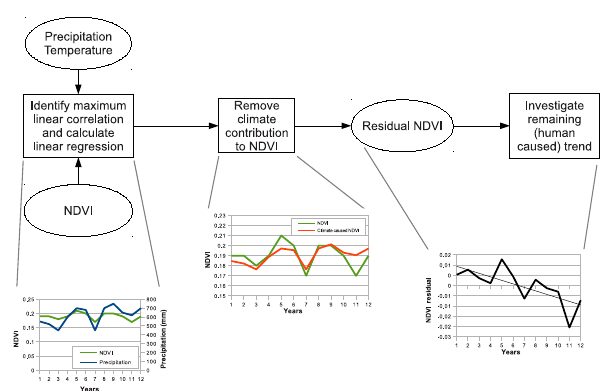
Fig. 2. Flowchart of RESTREND method to differentiate human vs. climate induced desertification. First, climate (precipitation, tem- perature) and vegetation (NDVI) time series are used to find the cli- mate averaging window that produces the highest correlation. Using this window, the linear regression is calculated. Then, this regres- sion equation is used to calculate the climate caused NDVI compo- nent. The difference between the observed NDVI and the climate caused NDVI is the NDVI residual. The trend in this residual indi- cates the human caused changes in the